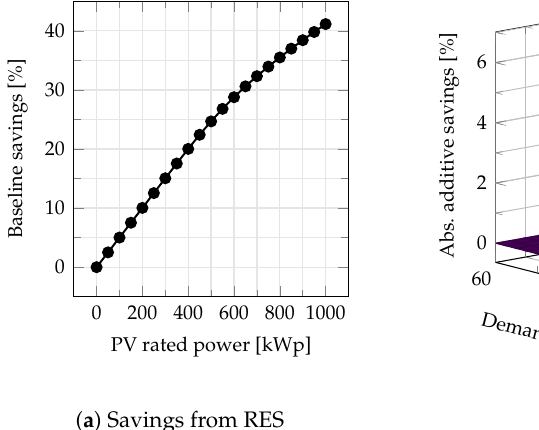
Figure 8. Results of the simulations showing the (baseline) total operating costs savings attributed only to the deployment of renewable energy (i.e., without demand flexibility) ( a ) and the additional savings that can be achieved with different levels of demand flexibility ( b ). All savings are calculated against the baseline with no demand flexibility and no renewable generation.